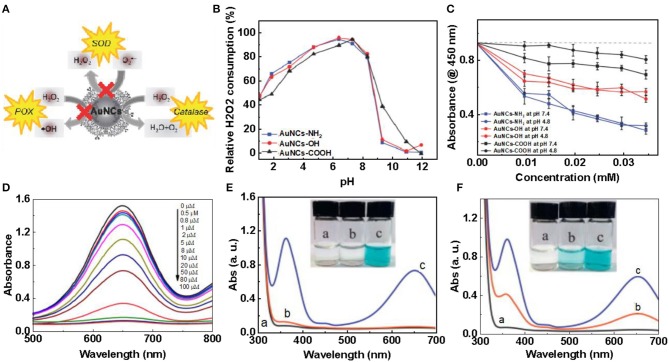
Catalase-like of gold clusters (A) Au NCs-NH2 can catalyze H2O2 to produce H2O and O2 through catalase-like activity. (B) Consumption of H2O2 by Au NCs-NH2, Au NCs-OH and Au NCs-COOH at the same concentration (0.02 × 10−3 M). (C) The catalytic activities of different concentrations of Au NCs-NH2, Au NCs-OH and Au NCs-COOH on H2O2 (0.1 × 10−3 M) at pH 4.8 and 7.4 [reproduced from Liu C. P. et al. (2017) with permission from The Small]. (D) Effects of different concentrations of Ag+ on catalase activity of BSA-Au NCs. Red BSA-Au NCs [reproduced from Chang et al. (2016) with permission from The Elsevier]. (E) And blue BSA-Au NCs. (F) Catalyze TMB under different conditions: (a) under visible light, (b) in the presence of Au NCs, (c) in the presence of Au NCs under visible light [reproduced from Wang et al. (2015) with permission from The Elsevier].